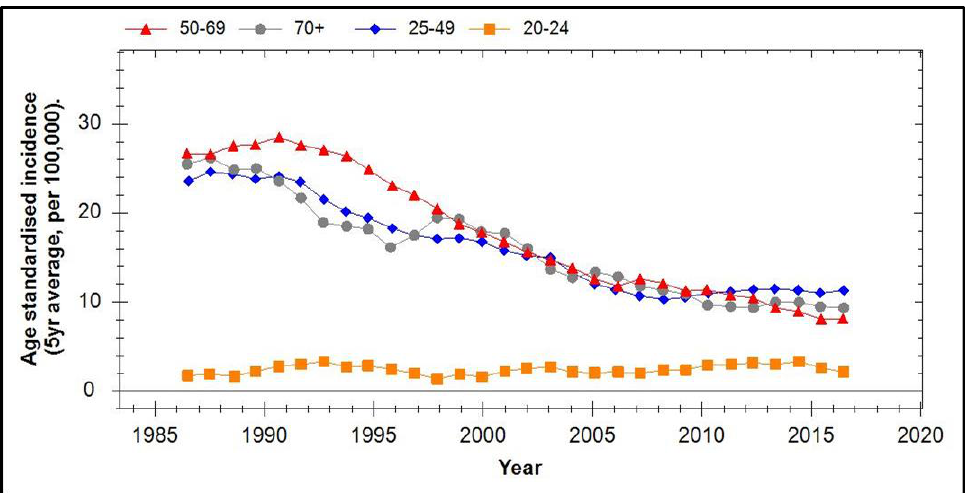
Figure 7. Five-year averaged age-standardised incidence of cervical cancer in New Zealand from 1987 to 2017.